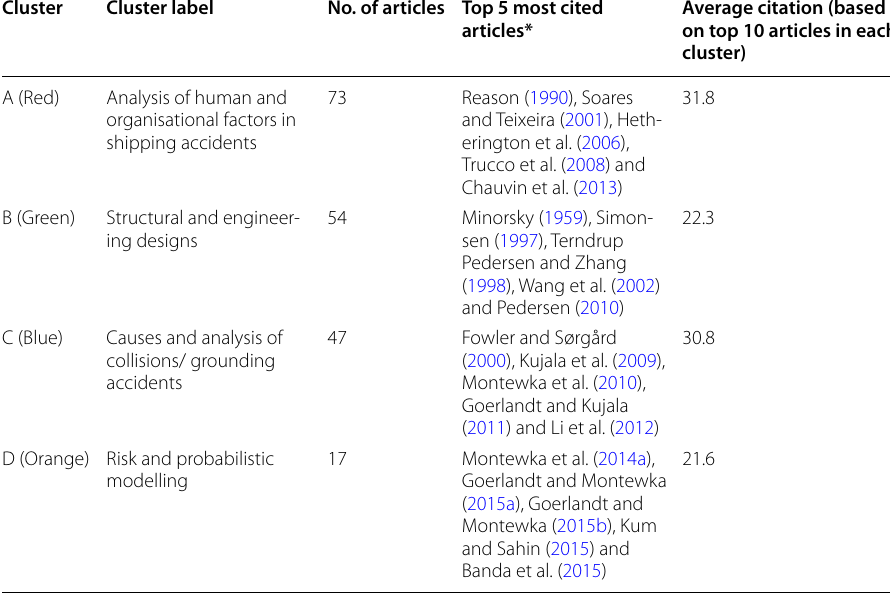
Table 2 References output indicators and citation impact related to stage 1 and Fig. 2